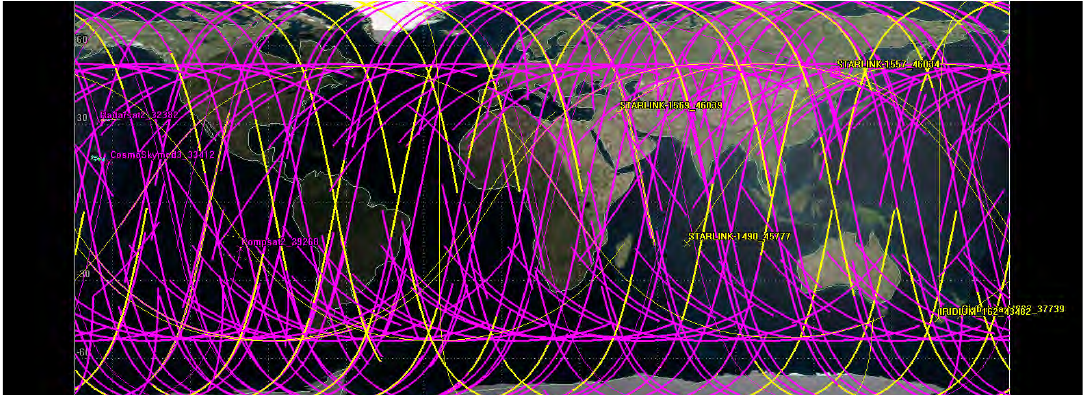
Figure 8. Two-dimensional trajectory of the